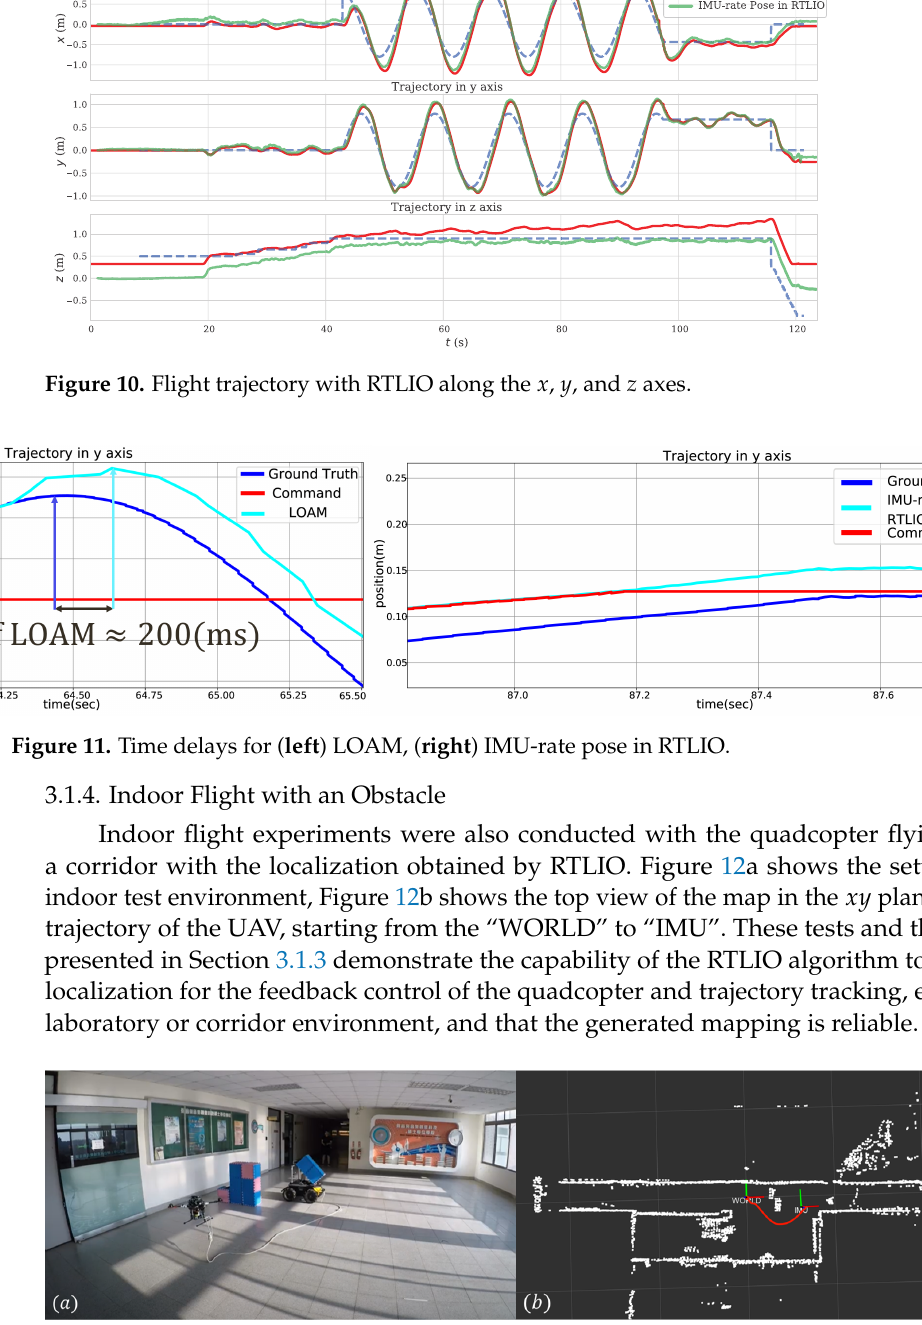
Figure 12. Results for indoor flying with a corridor: ( a ) setup ( b ) top view of the map and the trajectory of the entire flight (from WORLD to